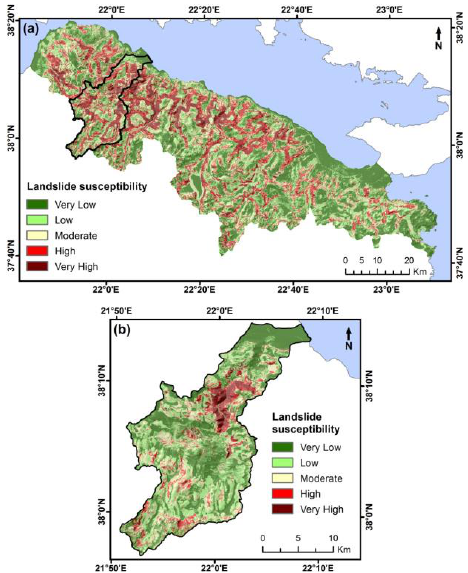
Figure 3. The landslide susceptibility maps produced by the model ( a ) for the regional scale analysis; ( b ) for the more detailed scale analysis.